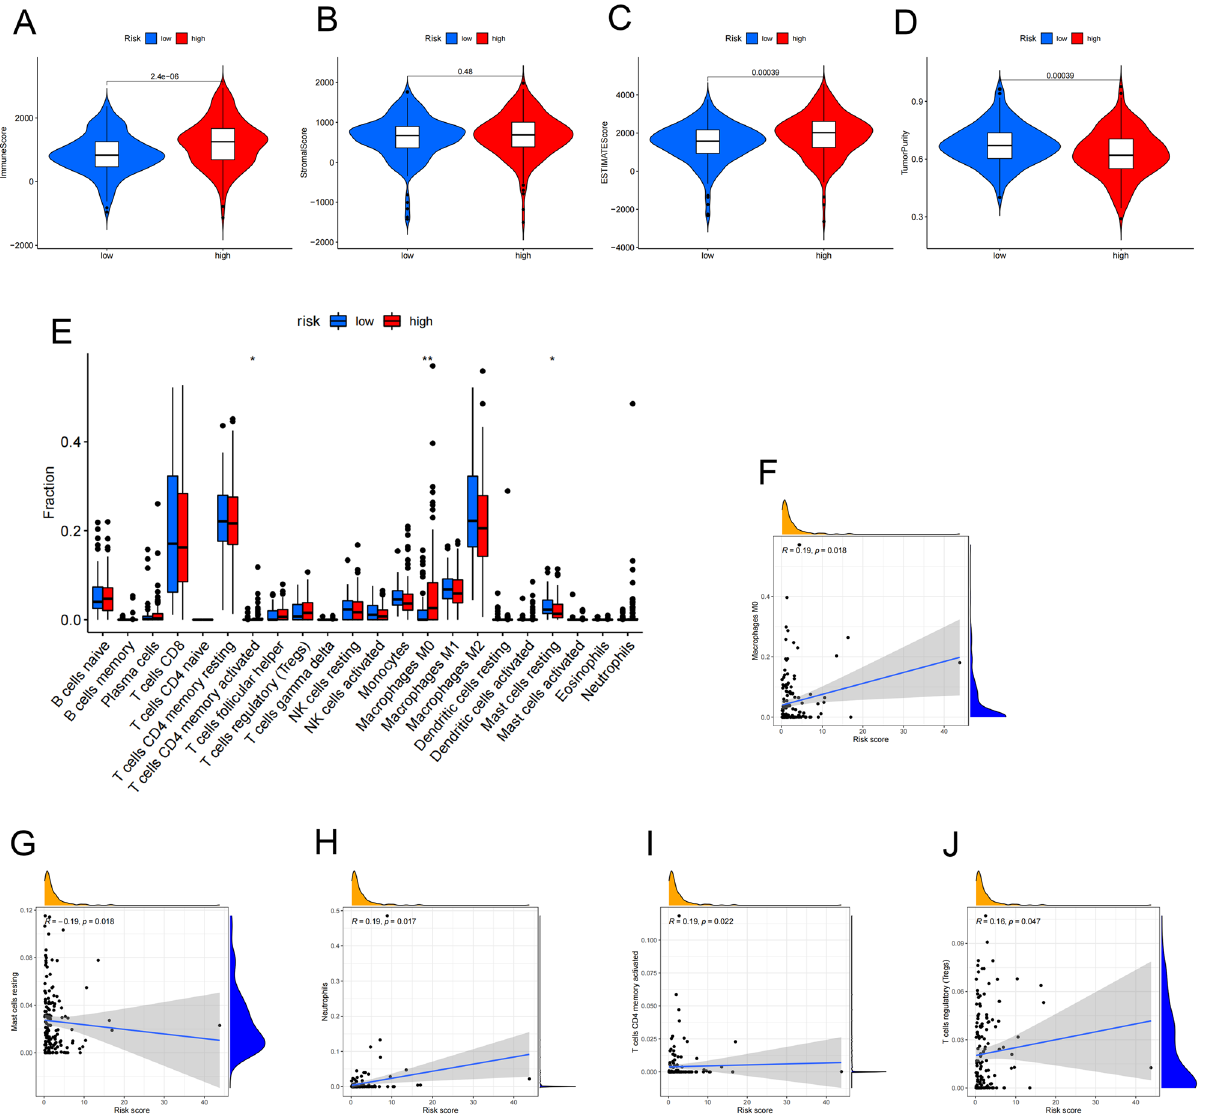
The correlation between the RS and significant ICGs. Red circles represent positive correlation and blue circles represent negative correlation. The strength of the correlation is determined by the size of the circle. ( F–G ) The scatterplots showed the correlation among five types of TIIC and the RS with P < 0.05 by Spearman’s rank correlation test. R > 0 indicated that the two were positively correlated, and vice versa. (*P < 0.05, **P < 0.01, ***P <